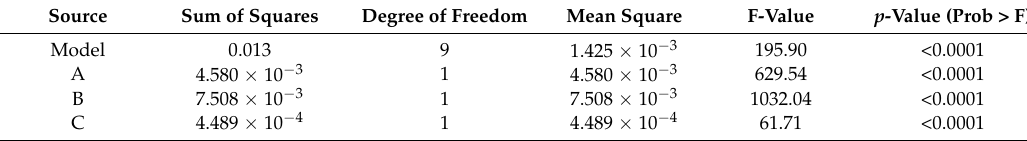
Table 3. Analysis of variance (ANOVA) table for